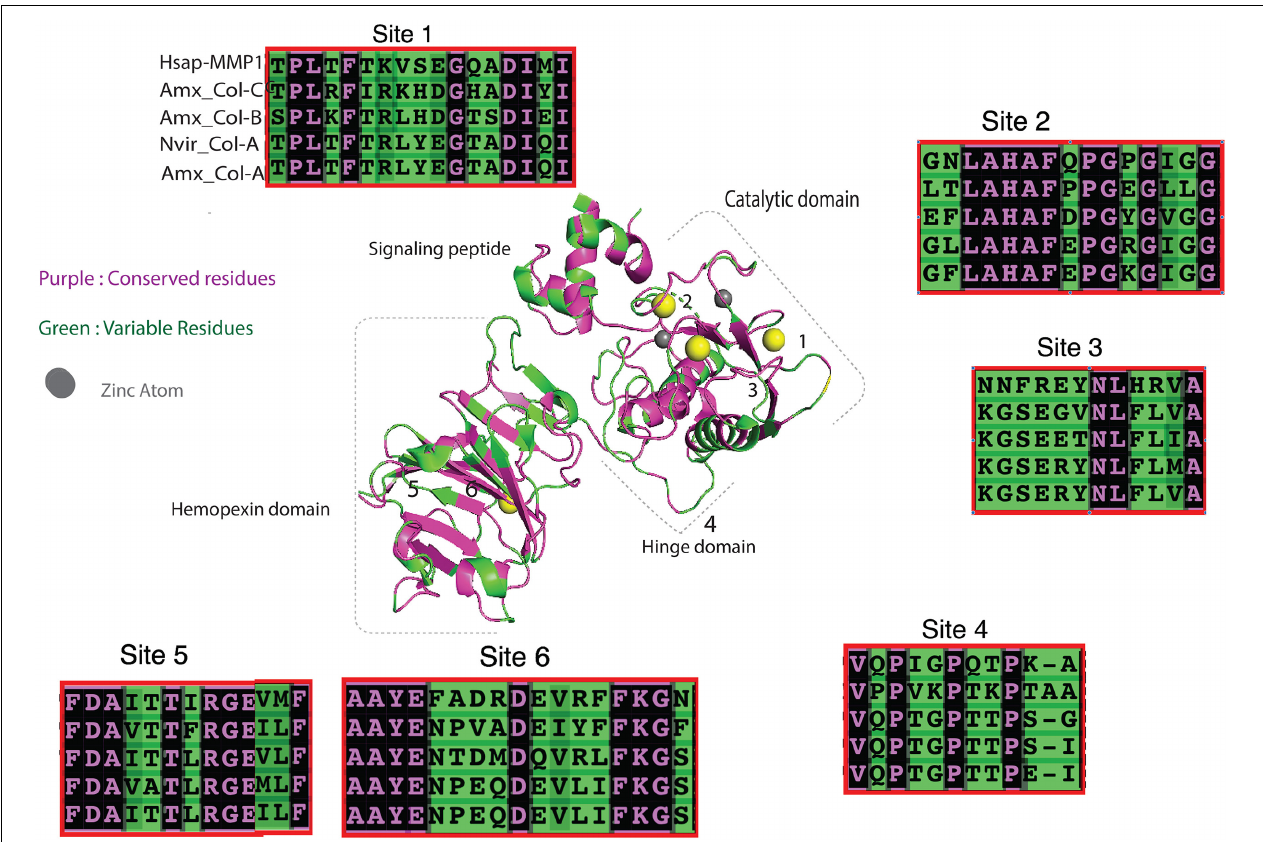
FIGURE 5 | 3D alignment of Nvir-Col-A, axolotl Collagenase (A–C) and human MMP1 protein sequences show variation in the collagen binding domain. Purple and green regions represent conserved and variable residues,